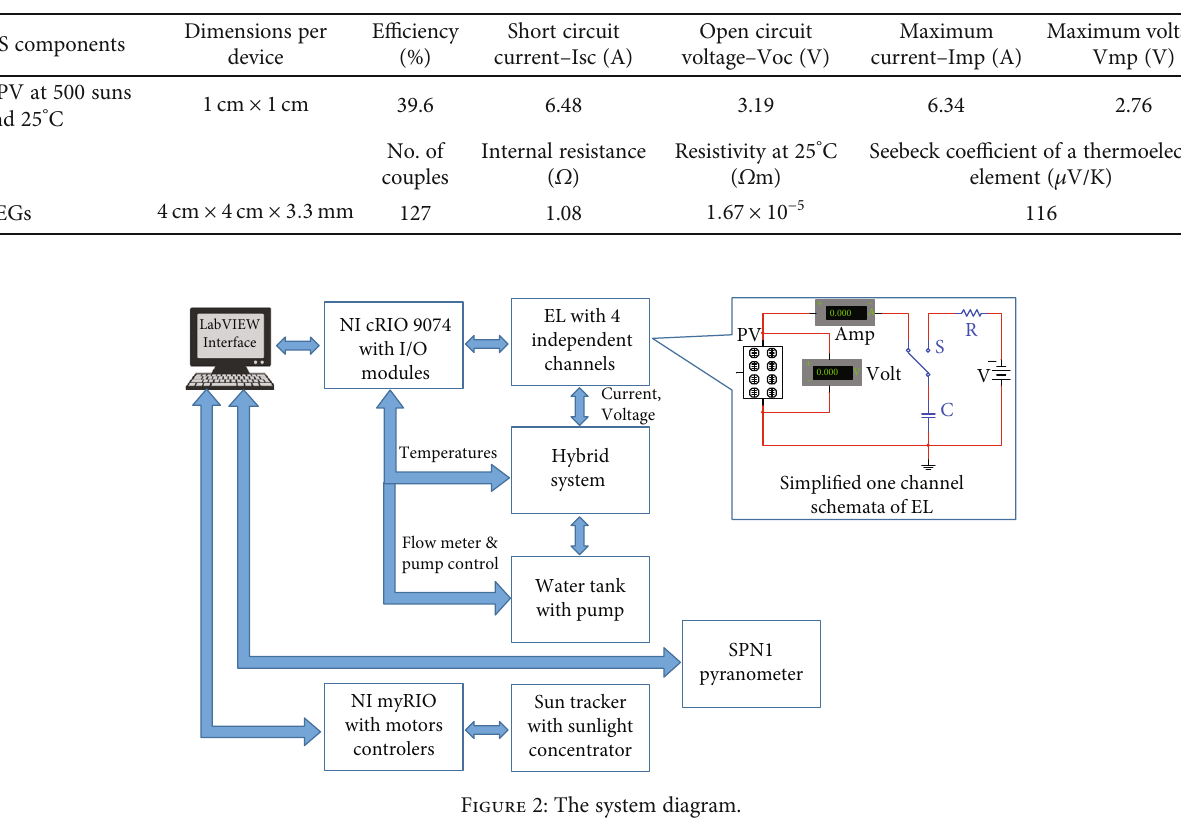
Figure 1: HS structure. Table 1: The CPV and TEG parameters according to their datasheet.